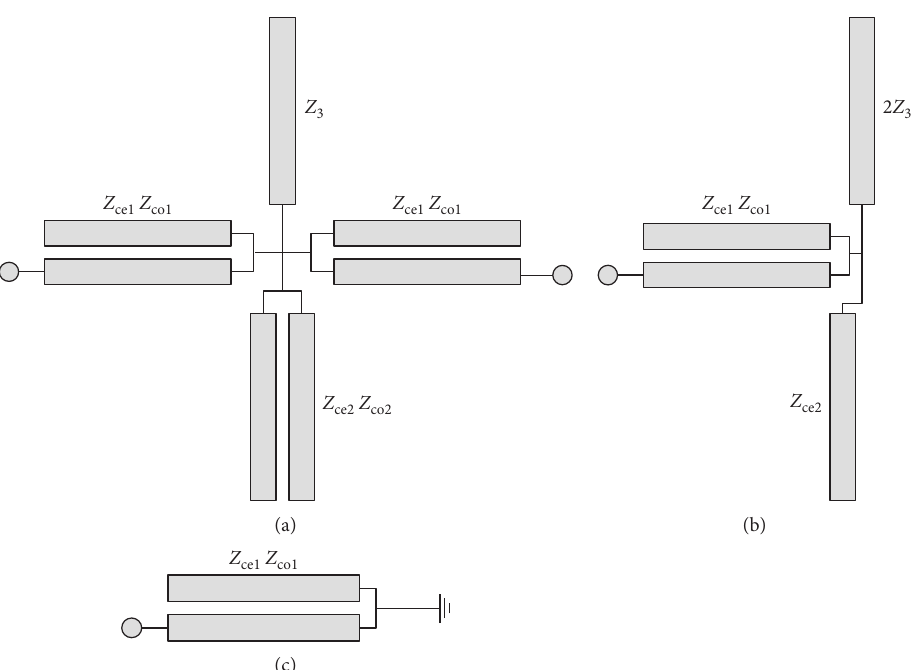
Figure 1: Ideal circuit of wideband BPF and its equivalent circuit model: (a) ideal circuit model; (b) odd-mode circuit; (c) even-mode circuit.